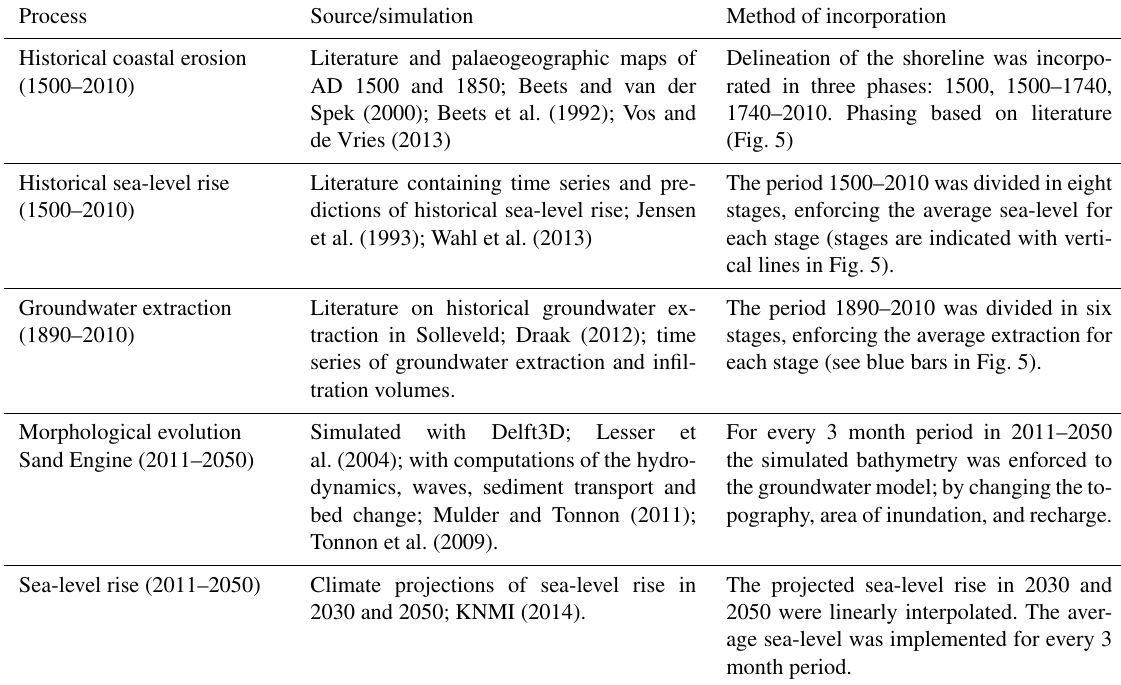
Table 2. Simulation of processes and method of incorporation in groundwater model.